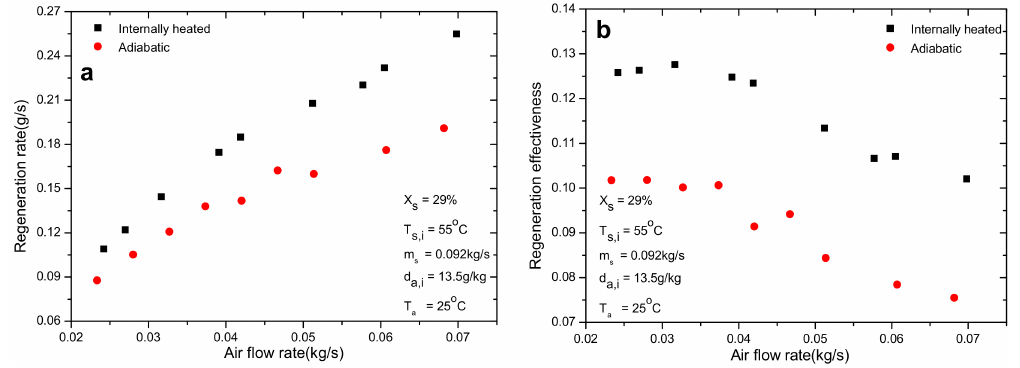
Figure 7. Effect of air flow rate on regeneration performance: ( a ) regeneration rate; ( b ) regeneration effectiveness.